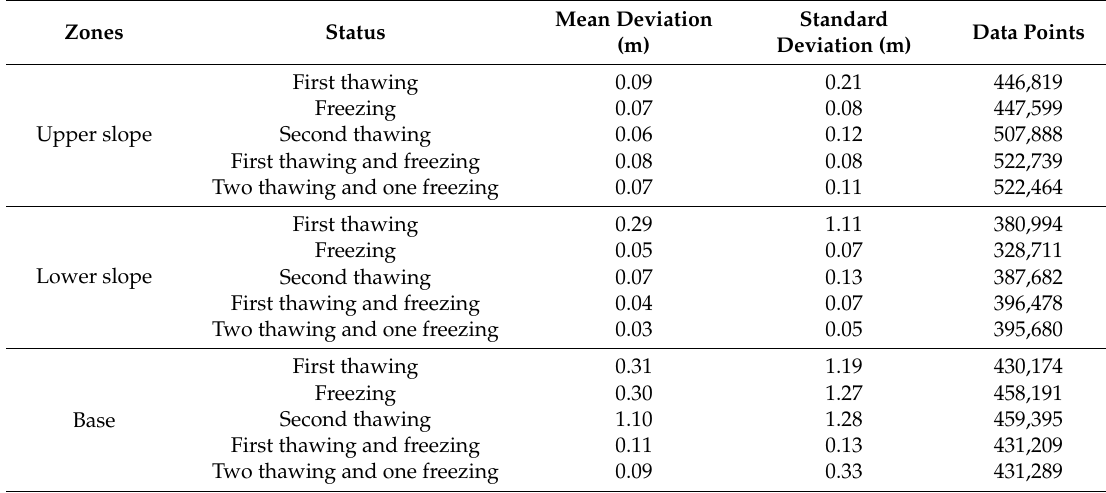
Figure 8. Normalized breakdown of the upper slope change mapped during the freeze–thaw cycles. NP denotes the normalized percentage. Table 4. Comparison of the topographical change statistics for different zones of the slope.